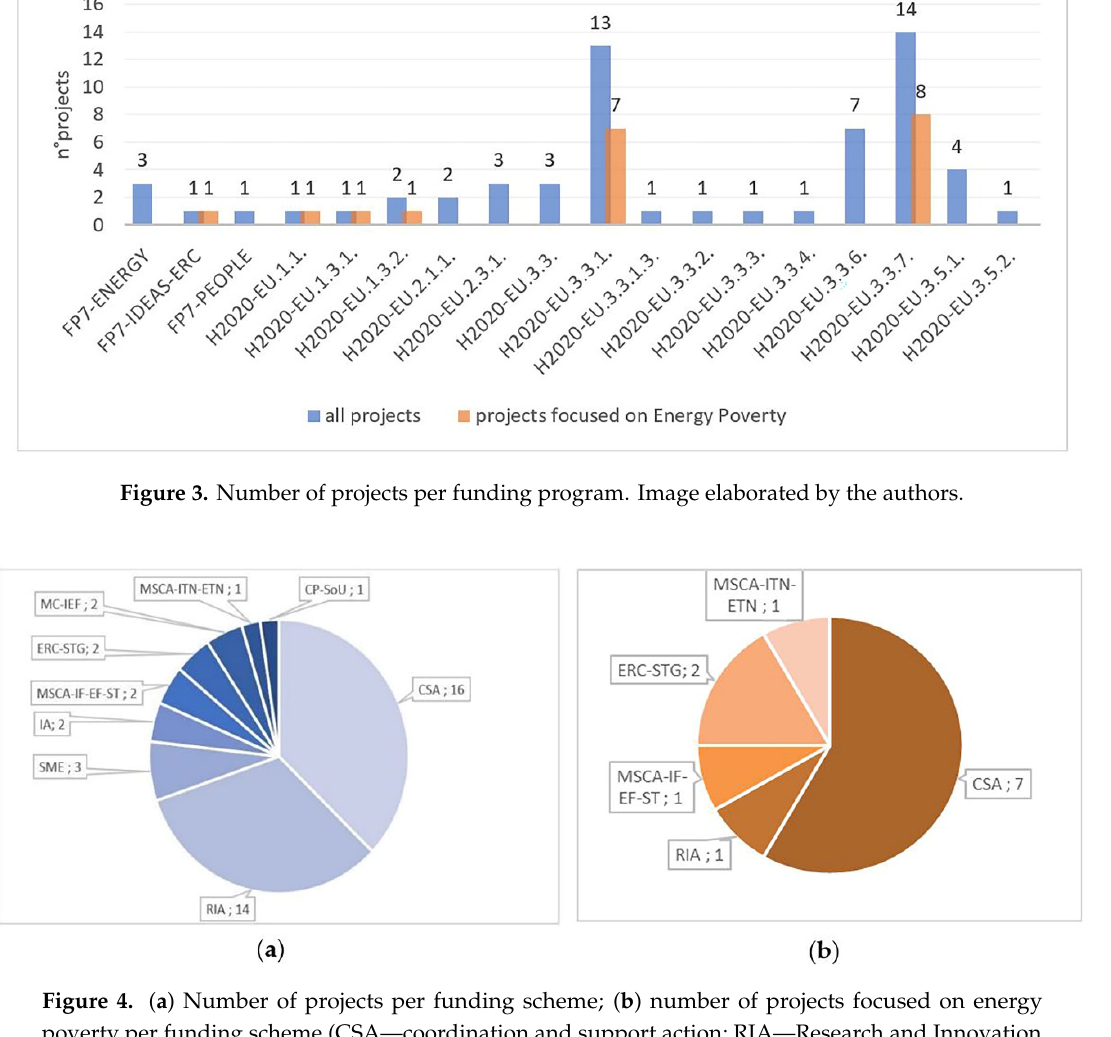
Figure 4. ( a ) Number of projects per funding scheme; ( b ) number of projects focused on energy